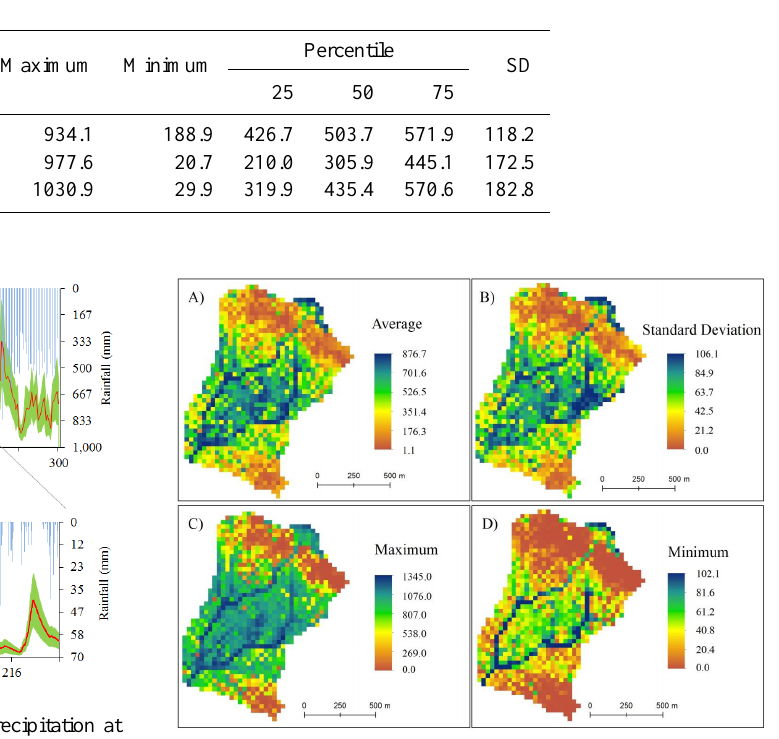
Fig. 10. Spatial distribution of simulated pasture production (kg DM ha − 1 ) : (A) average; (B) standard deviation; (C) maximum; (D)